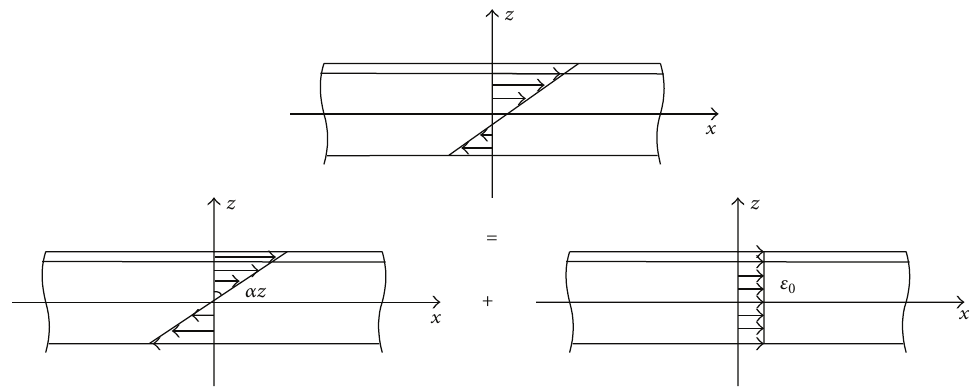
Figure 8: Asymmetric strain condition of a plate with a single actuator